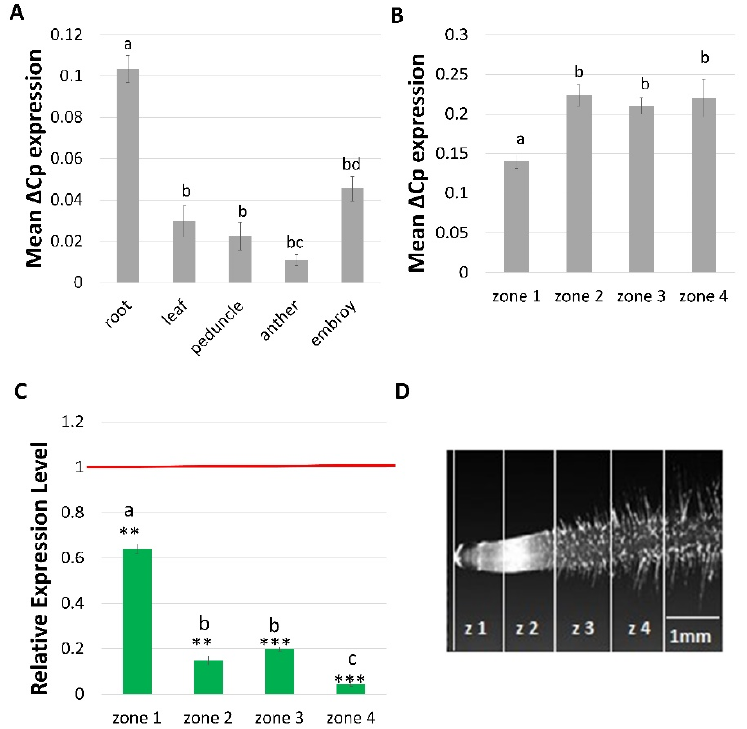
Figure 5. Expression profile of HvCSLC1 gene in ( A ) various organs and ( B ) four root zones of WT cv. ‘Sebastian’. ( C ) Relative expression level of HvCSLC1 in four root zones of rhp1.e mutant normalized to the gene expression in the corresponding zone of WT, which was considered as the value 1 (red line). Root zones: 1—meristematic, 2—elongation, 3—differentiation and 4—developed root hair zone. Different lowercase letters indicate the significant differences between analyzed organs ( A ) and root zones (B) of the WT ‘Sebastian’ and root zones of rhp1.e mutant ( C ) according to the One Way ANOVA, Tukey’s HSD test ( p < 0.05). Asterisks indicate the significant differences between the mutant and WT parent according to the Student’s t test (*** p < 0.001; ** p < 0.01). Graph shows mean values of n = 3 with SEM. ( D ) Root zones that were used for analysis of gene expression (based on Kwasniewski et al., 2010 [47]).